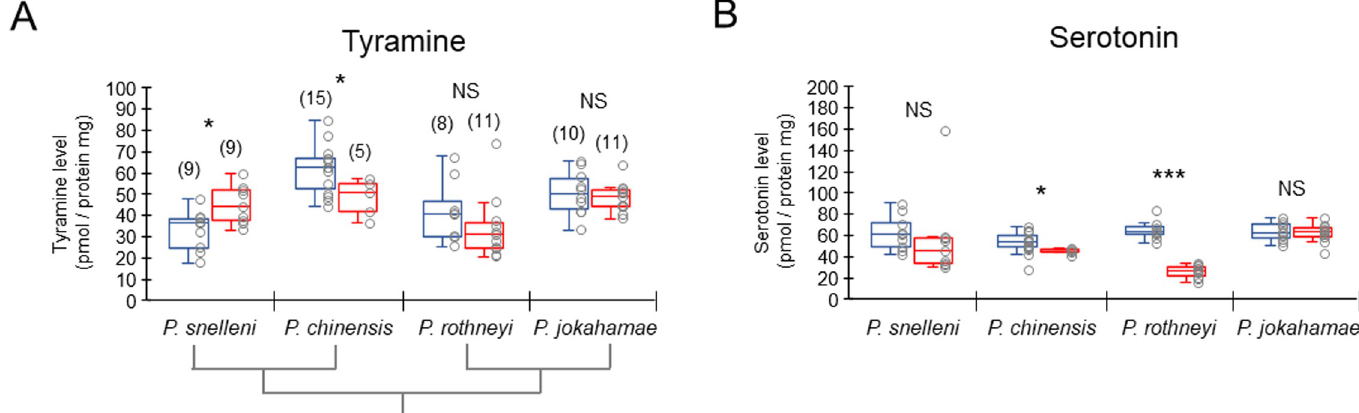
Fig 3. Amounts of tyramine and serotonin in the brains of the workers and gynes of four species of Polistes paper wasps. (A) Tyramine levels and (B) serotonin levels. Blue and red box plots indicate workers and gynes, respectively. The number of samples examined for serotonin is the same as those for tyramine. Asterisks in the graph indicate significant differences between workers and gynes ( � : P < 0.05, ��� : P < 0.001, NS: not significant, P > 0.05). The phylogenetic relationship is indicated below the X-axis in (A).